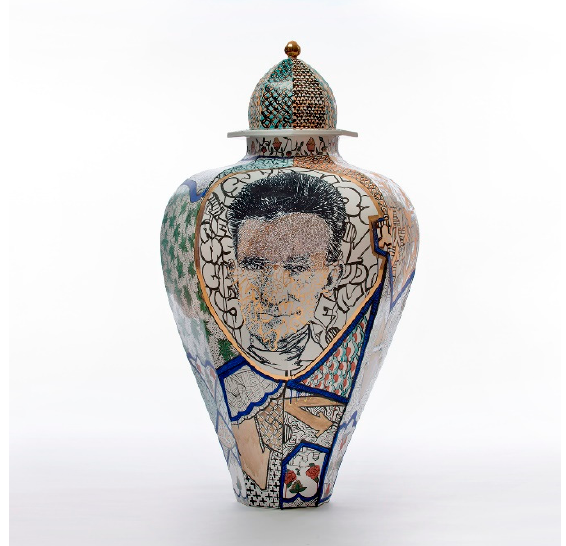
Figure 2. The Expulsion of Colin Kaepernick and John Brown, 2017 , Porcelain, china paint, luster, 47 × 24 × 24 in. Image by KeneK Photography, courtesy of Wexler Gallery.